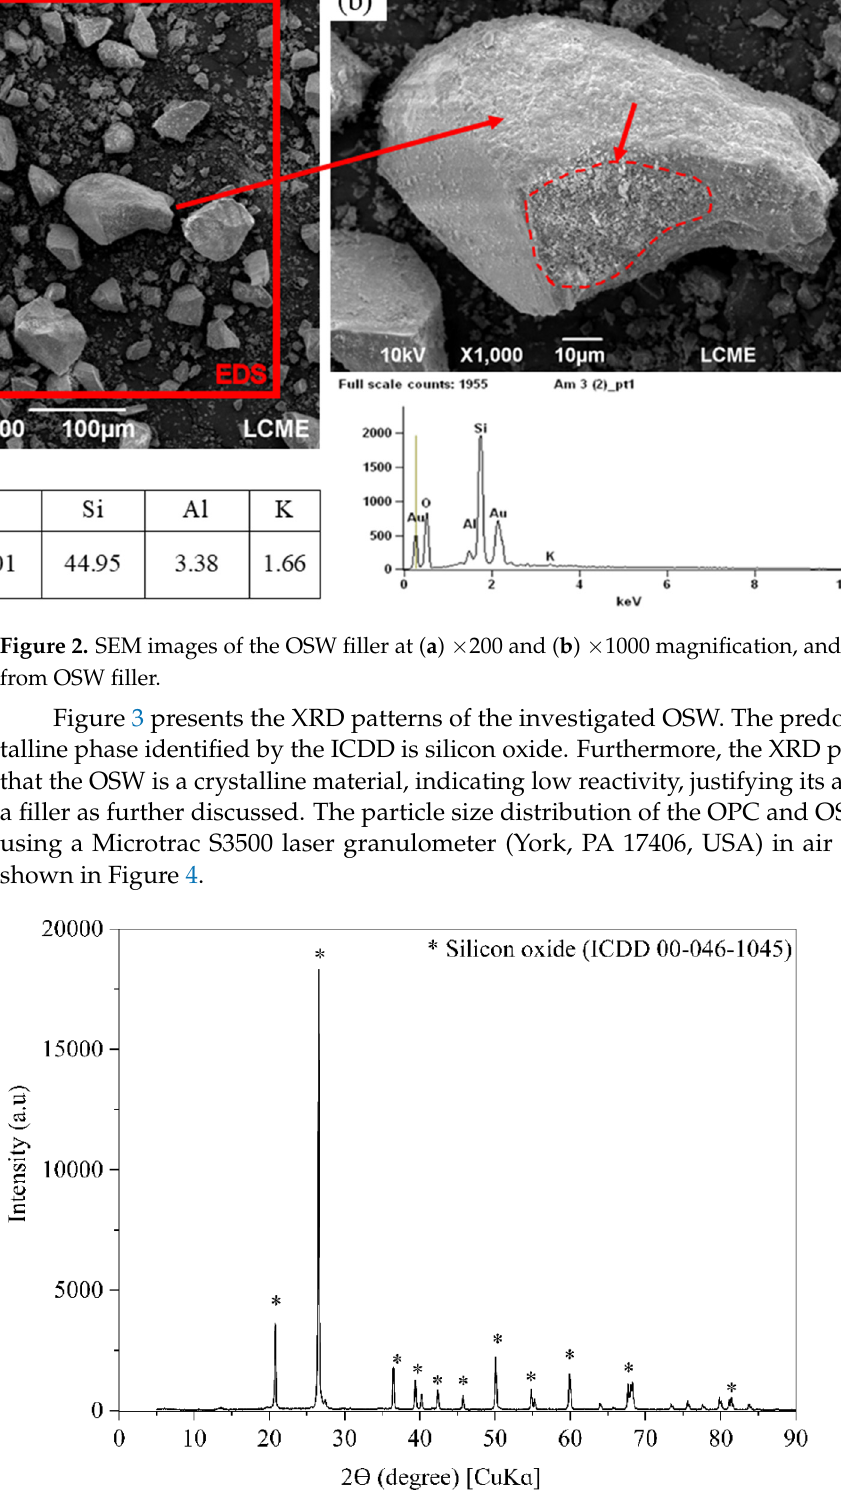
Figure 4. Particle size distribution of OPC and OSW. 3.2. Isothermal Calorimetry Figure 5 shows the heat evolution curves of all pastes investigated. The values were normalized for the cement mass of the samples. It was observed that the main heat flow peak slightly increased with the increase in OSW content up to 30 wt.%. The main peak of heat (dominated by the growth of hydrates C–S–H and portlandite [37]) increased from 5.79 mW/g (REF) to 5.91–5.99 mW/g (OSW10–OSW30). Furthermore, as the replacement level increased, the 90-h cumulative heat increased. The incorporation of OSW resulted in increases in cumulative heat from 347 J/g (REF) to 389 J/g (OSW30). This increase indicates a slight improvement in cement hydration due to the presence of the sandstone. Besides that, the increase in OSW content progressively anticipated the main peak heat release from 10:02 h (REF) to 9:28 h (OSW30). On the first day, the enhancement of cement hydration is due to the filler effect, which can be attributed to the dilution effect [37]. The